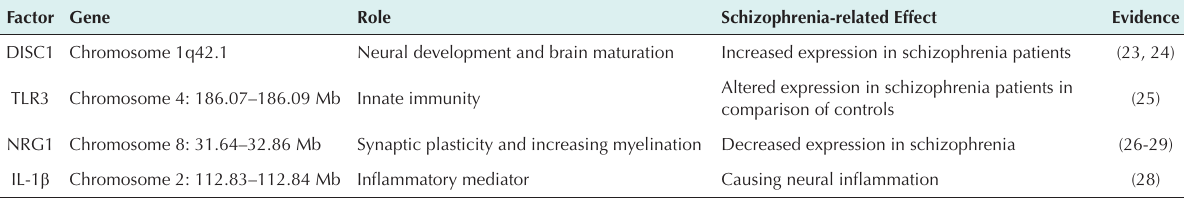
Table 1. Most Important Cytokines of Schizophrenia Development Factor Gene Role Schizophrenia-related Effect DISC1 Chromosome